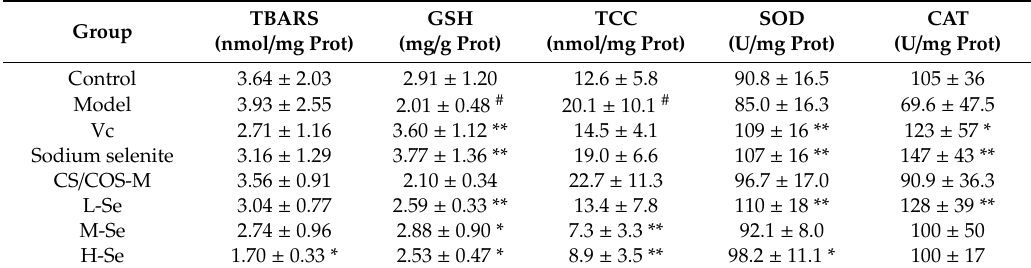
Table 7. Hepatic biomarkers of KM mice ( n =